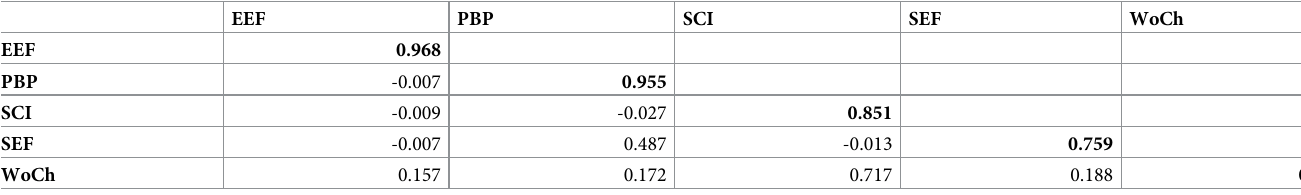
Table 3. Discriminant validity: Fornell-Larcker